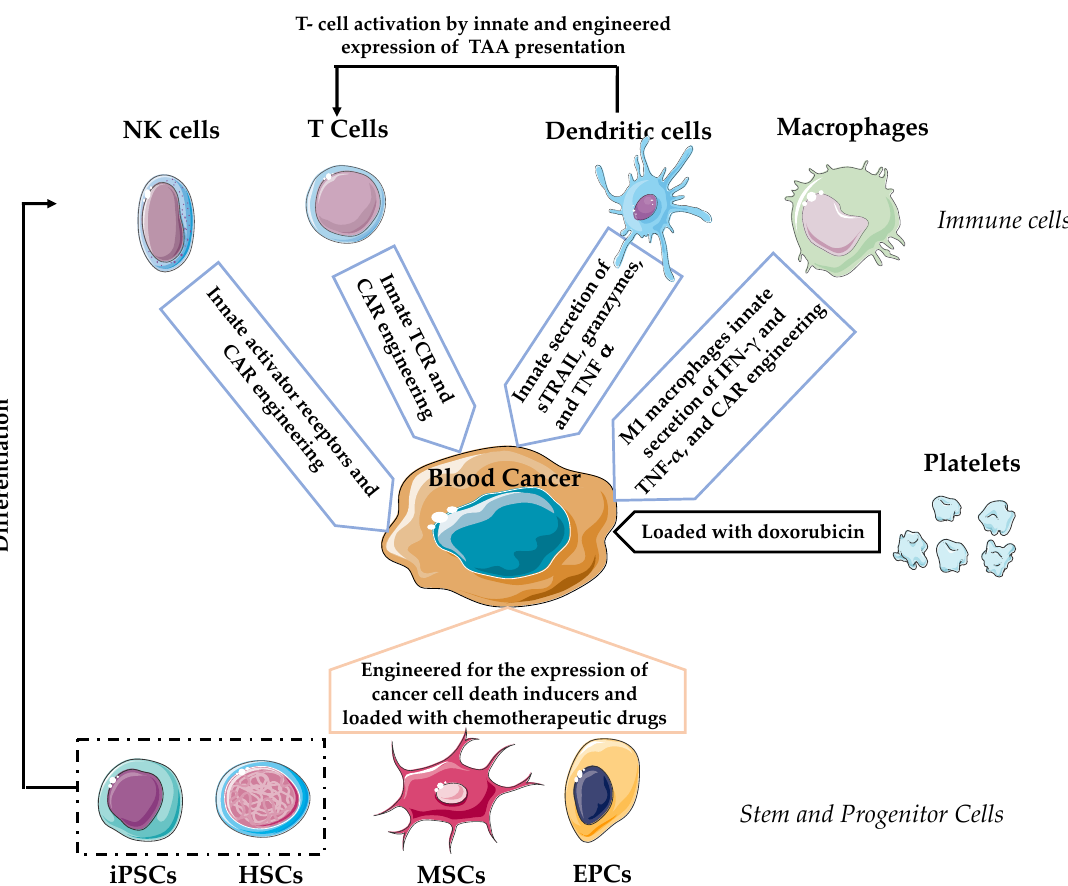
Figure 1. Diagram depicting the di ff erent cell-based therapies to treat hematological malignancies with the mode of action in each case. NK: natural killer, iPSCs: induced pluripotent stem cells, HSCs: hematopoietic stem cells, MSCs: mesenchymal stem cells, and EPCs: endothelial progenitor cells.